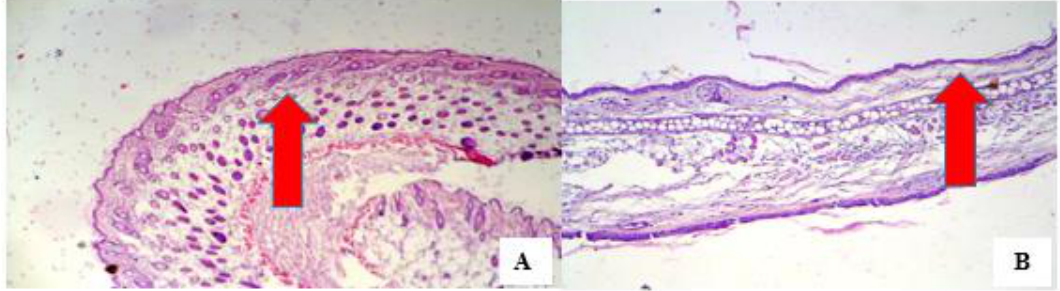
Figure 1. (H and E) staining sections of the mouse back area skin and ear skin of control group (200X) A: section of normal right ear B: section of the back area. Red arrows : sign to the thickness of the epidermal layer of back area and right ear section. acanthosis of stratified epithelium more than 6 In the (vehicle susp + IMQ) group cells with an increase of rete ridge as in Figure section of back area skin and right ear (2A and showed slight